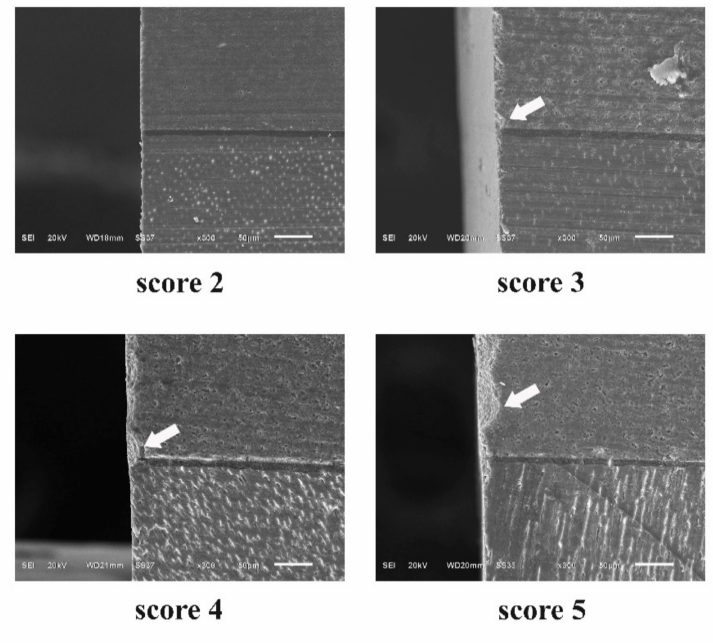
Figure 7. Representative SEM images of each defect score.